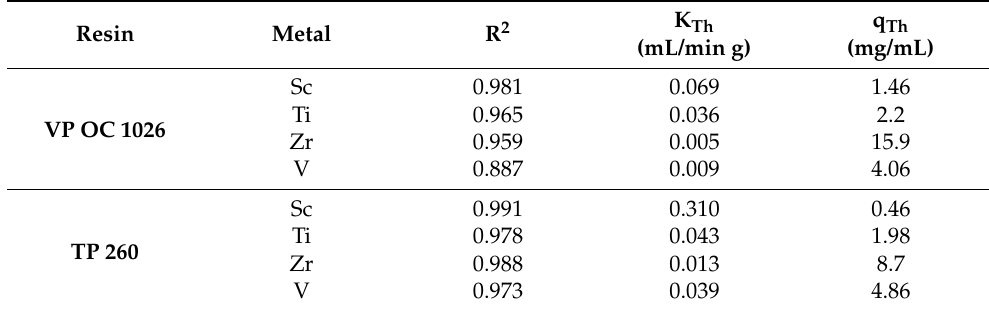
Table 3. The results of nonlinear regression analysis with Thomas mathematical model for VP OC 1026 and TP 260